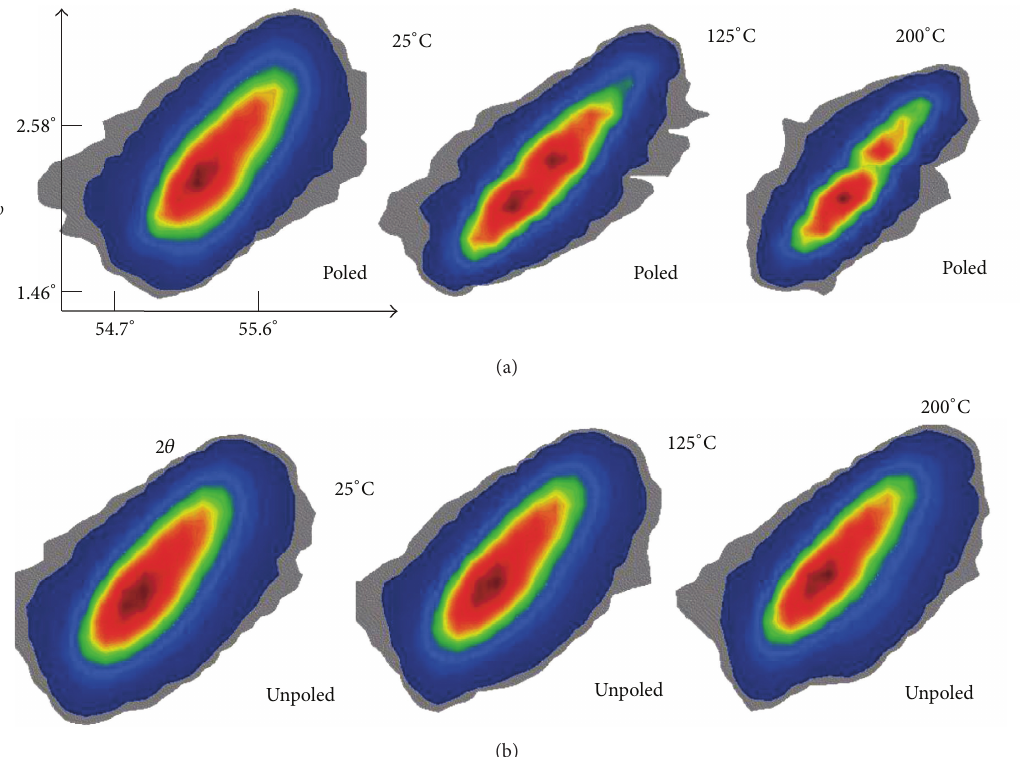
Figure 3: Contour of (002) reflection for [001] -poled (upper row) and unpoled (lower row) 0.29PIN-0.44PMN-0.27PT single crystals, at three selected